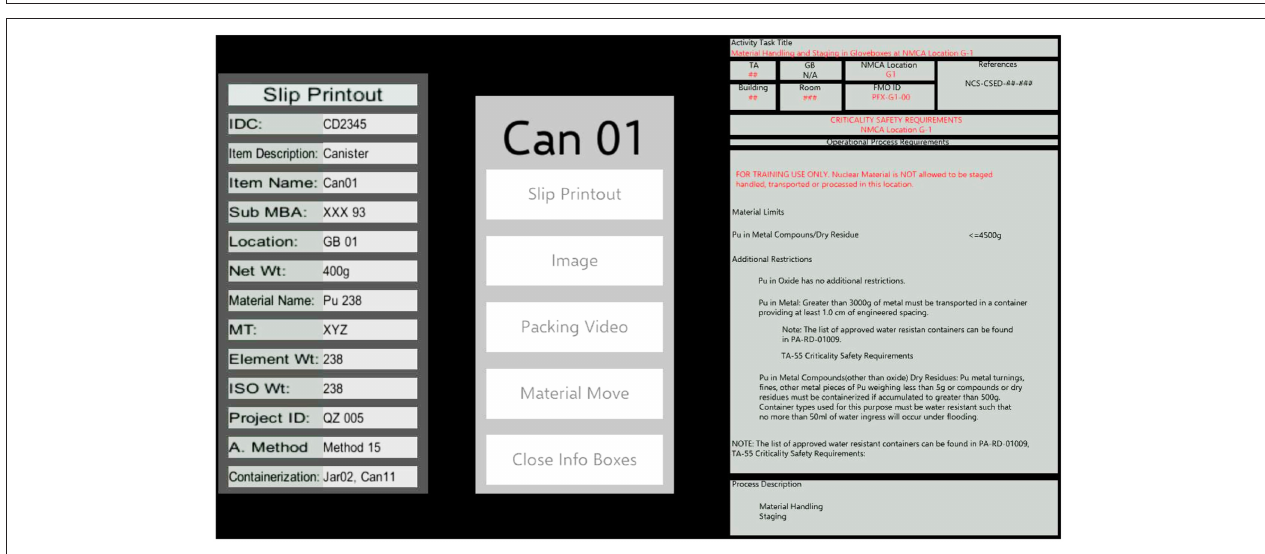
FIGURE 8 | Orthorectified view of the menu visible to the